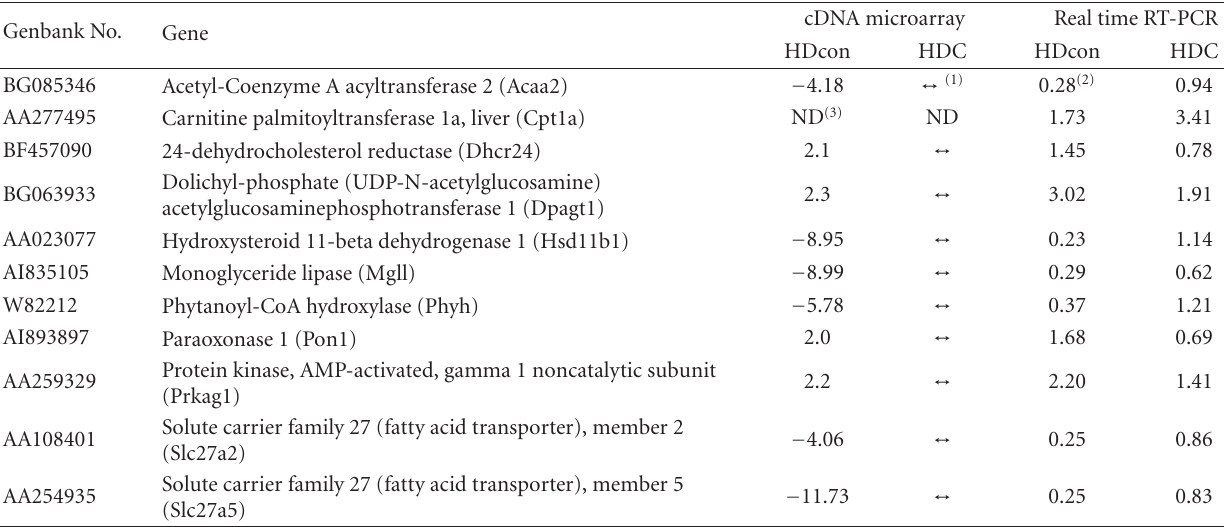
Table 5: Comparison between cDNA microarray analysis and real-time RT-PCR. Genbank